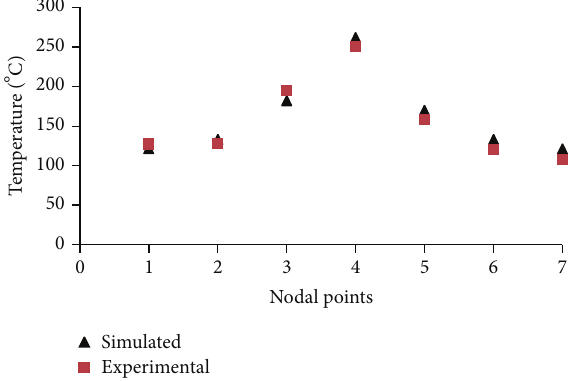
Figure 7: Temperature distribution at full